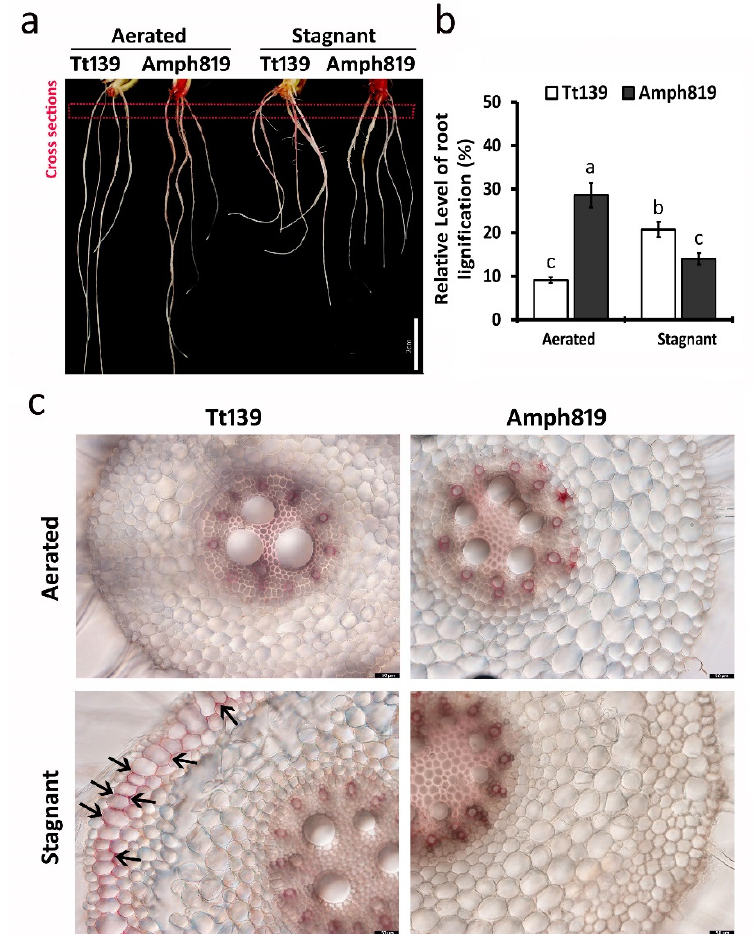
Figure 4. Patterns of secondary roots lignification in seedlings grown under aerated and stagnant conditions for 2 weeks. ( a ) Secondary roots were stained by 1% phloroglucinol-HCl for 30 min. The red staining on roots indicates the deposition of lignin. ( b ) The relative level of root lignification. These data are based on the ratio of lignin staining length (red color)/root length. Values are means ± SE ( n = 6) from 3 plants in each treatment. Letters indicate significant differences between means, determined using Duncan’s multiple range test (5% α ). ( c ) Cross-sections stained by phloroglucinol- HCl for 5 min and viewed under white light. Lignin in cell walls was detected by red staining. Arrows indicate the deposition of lignin in exodermis cells. Scale bars = 2 cm ( a ), and 50 μ m ( c ).